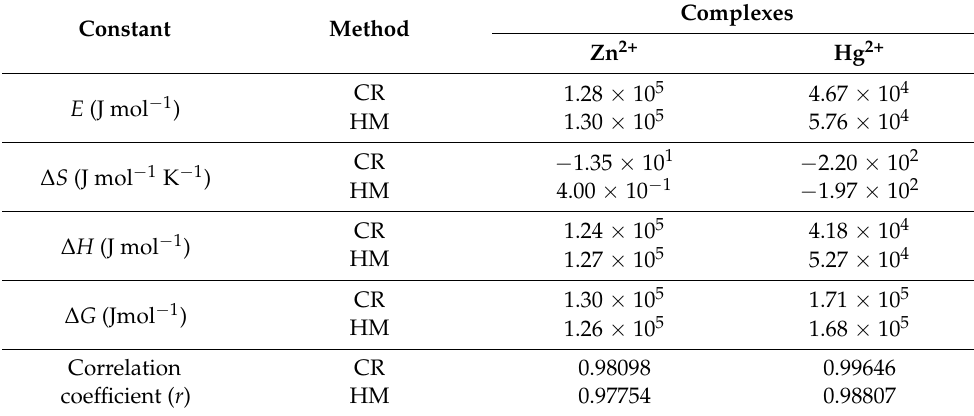
Table 1. The thermodynamic constants of Zn 2+ and Hg 2+